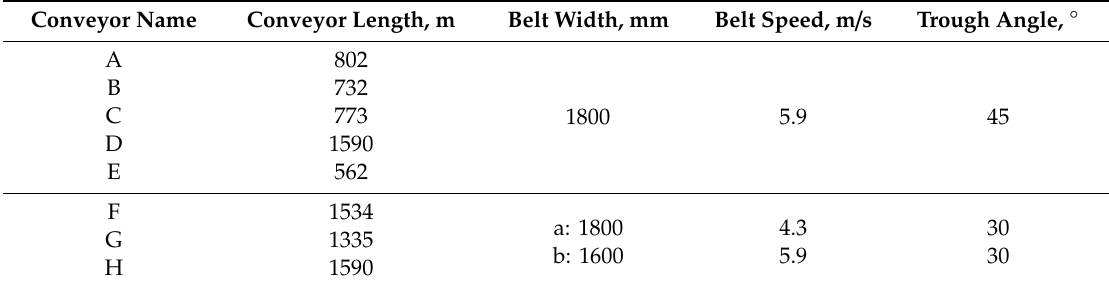
Table 2. Parameters of the belt conveyors in the existing transportation system.